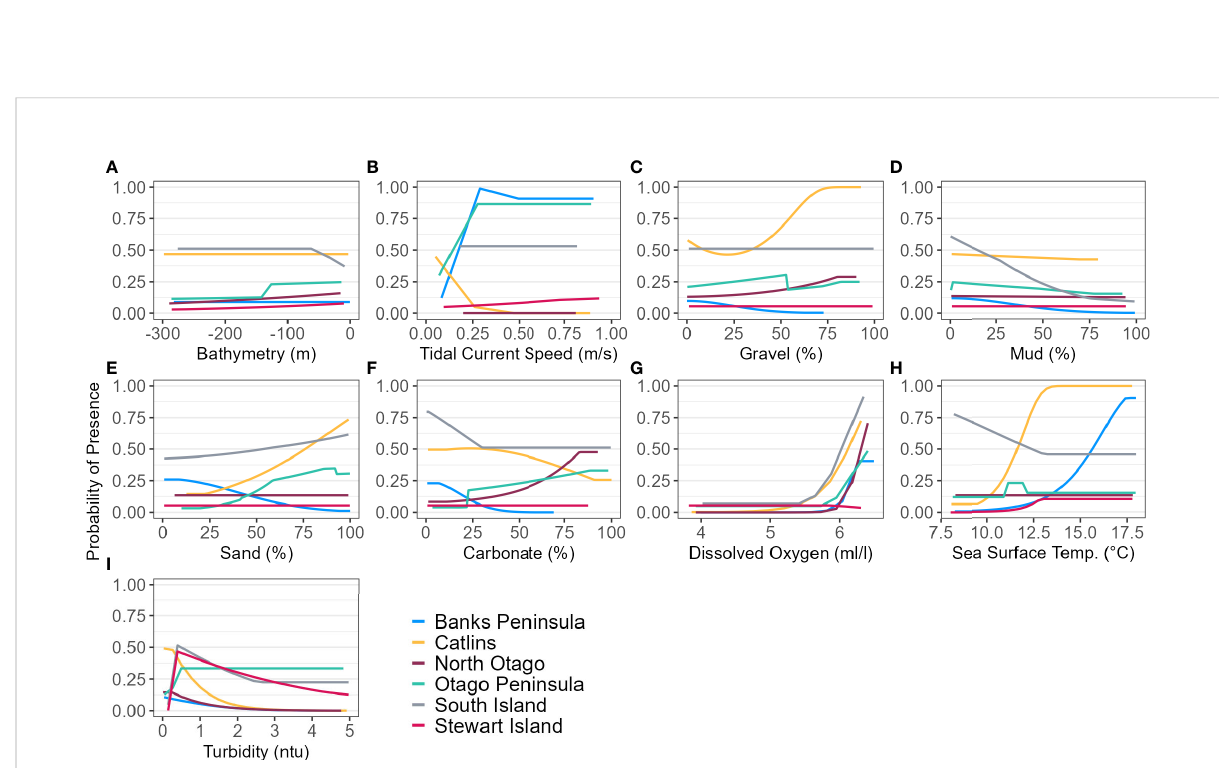
FIGURE 5 Response curves of each environmental predictor (A-I), excluding distance to colony, for each regional and South Island (SI) Maxent model predicting yellow-eyed penguin marine distribution.